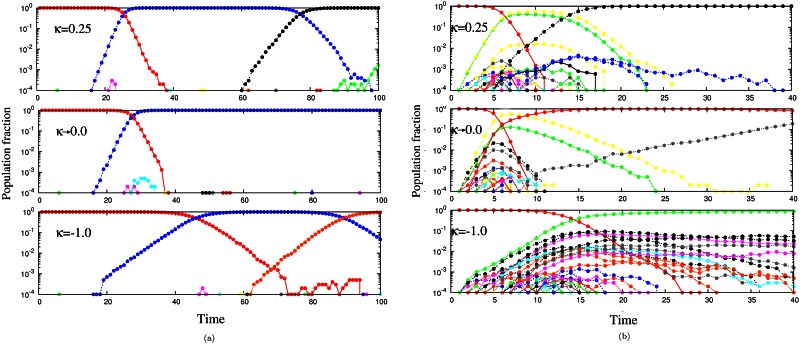
Population fraction of different mutant classes are shown as different coloured lines, where (a) shows the SSWM (Nμ = 0.1, low mutation rate) regime and (b) shows the high mutation (Nμ = 10) regime for all three EVT domains of DBFE.